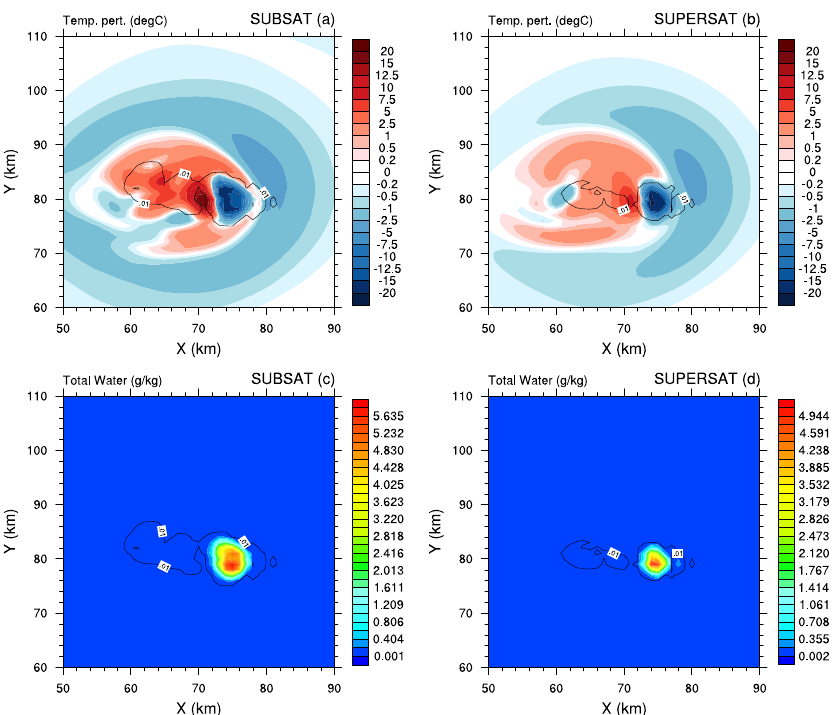
Fig. 4. Horizontal cross-sections at 18km at t = 40min. (a) SUBSAT and (b) SUPERSAT perturbation temperature (Celsius), and (c) SUBSAT and (d) SUPERSAT total water mixing ratio (gkg − 1 ). The black line indicates the 0.01gkg − 1 total cloud mixing ratio contour (marking the cloud boundary).